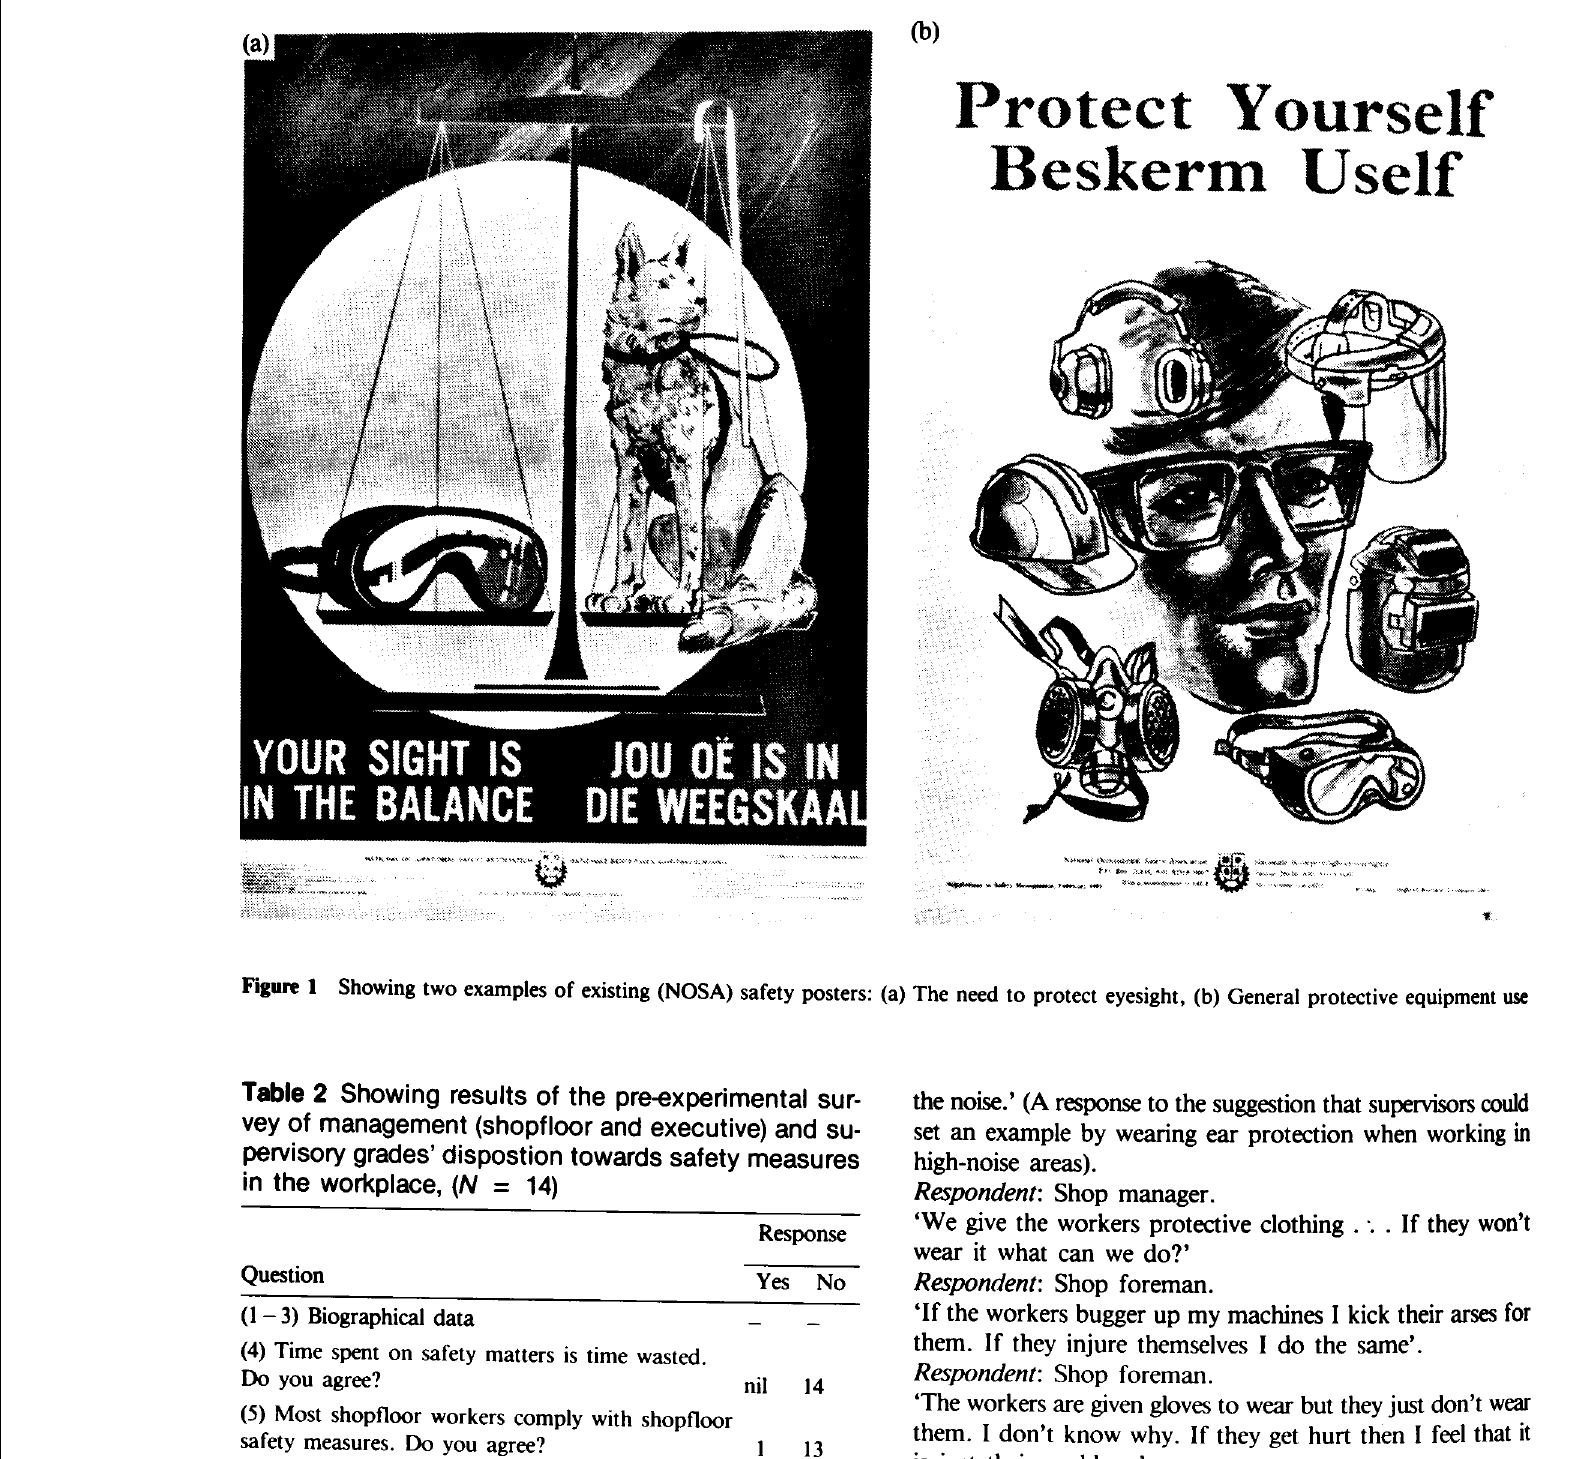
Table 2 Showing results of the pre-experimental sur vey of management (shopfloor and executive) and su pervisory grades' dispostion towards safety